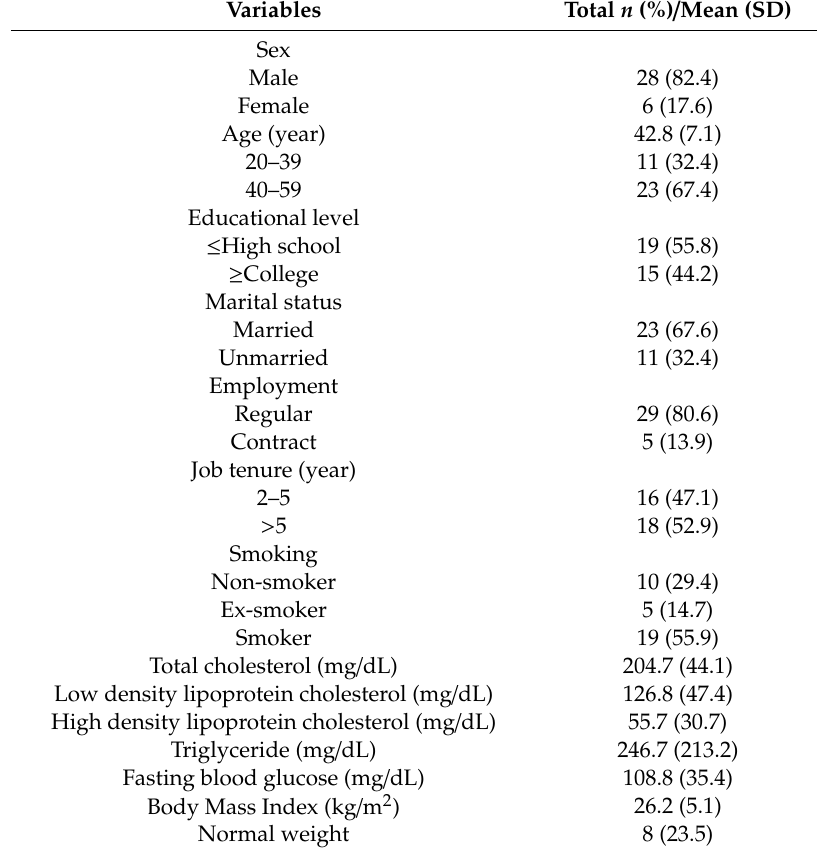
Table 2. General characteristics of the study population ( n =